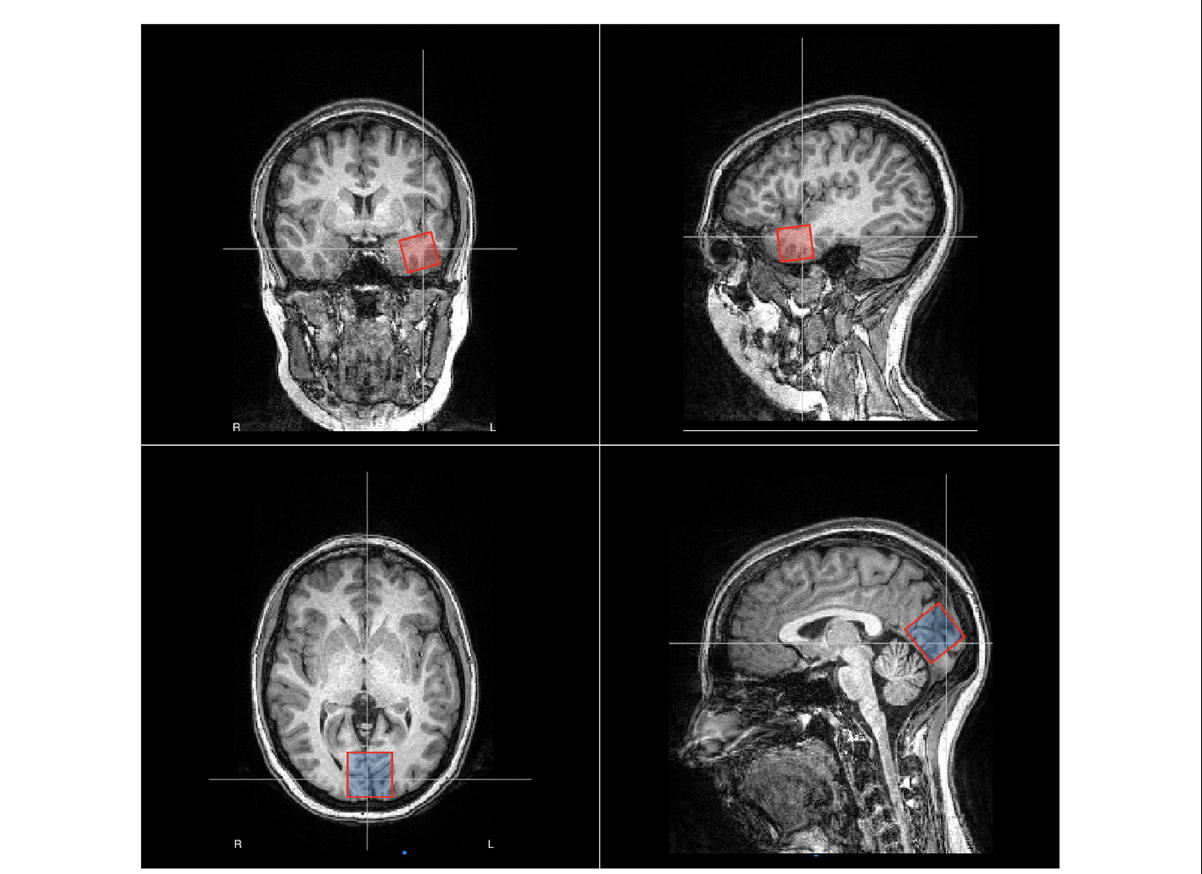
FIGURE1 Placement of the voxels for magnetic resonance spectroscopy (MRS) in patient no. 2, male, age 32 years. In red, we show the EZ voxel, which is positioned in the left anterior temporal lobe whereas in blue we show the reference voxel, which is positioned in the occipital zone medially. The EZ voxel was measured 25 × 25 × 25mm whereas the occipital voxel was measured 30 × 30 × 30mm.